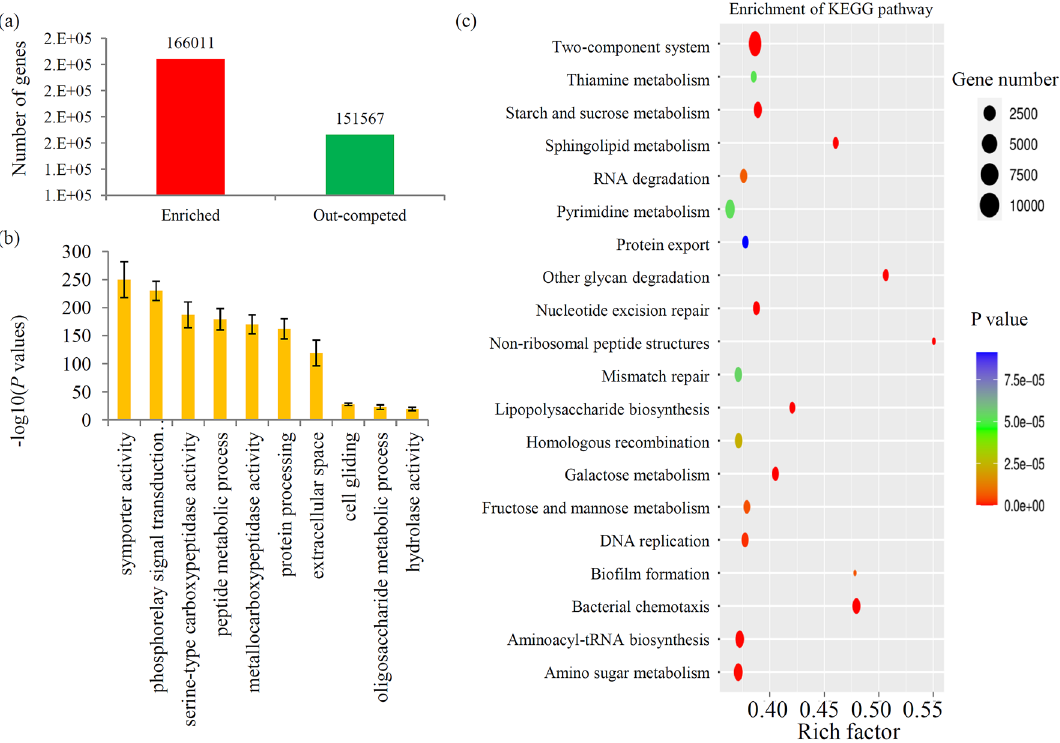
Figure 2. Enrichment analysis of the genes during the treatment. ( a ) The number of enriched and out- competed genes after treatment. ( b ) GO significance analysis of the differential genes between the CS and TS sample. ( c ) KEGG significance analysis of the differential genes between the CS and TS sample.